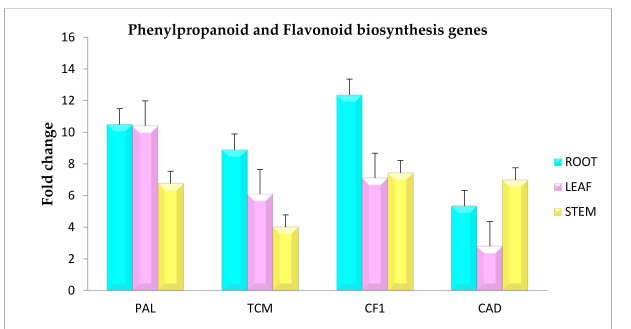
Figure 3. Validation of gene expression of phenylpropanoid and flavonoid biosynthesis genes by real-time PCR from Sida